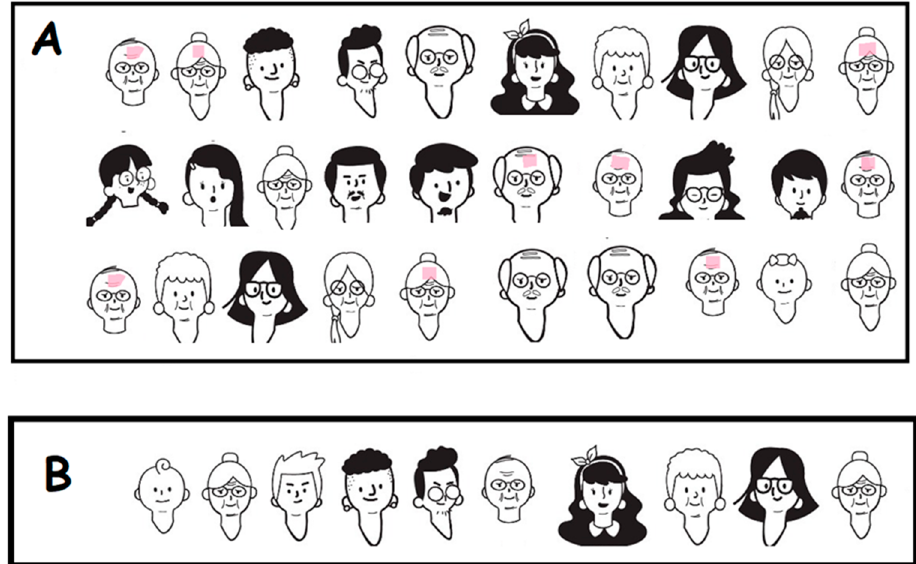
Figure 11. Training set ( A ) and test set ( B ), with patients. The ones in the training set ( A ) with pink mark on their foreheads are ill.